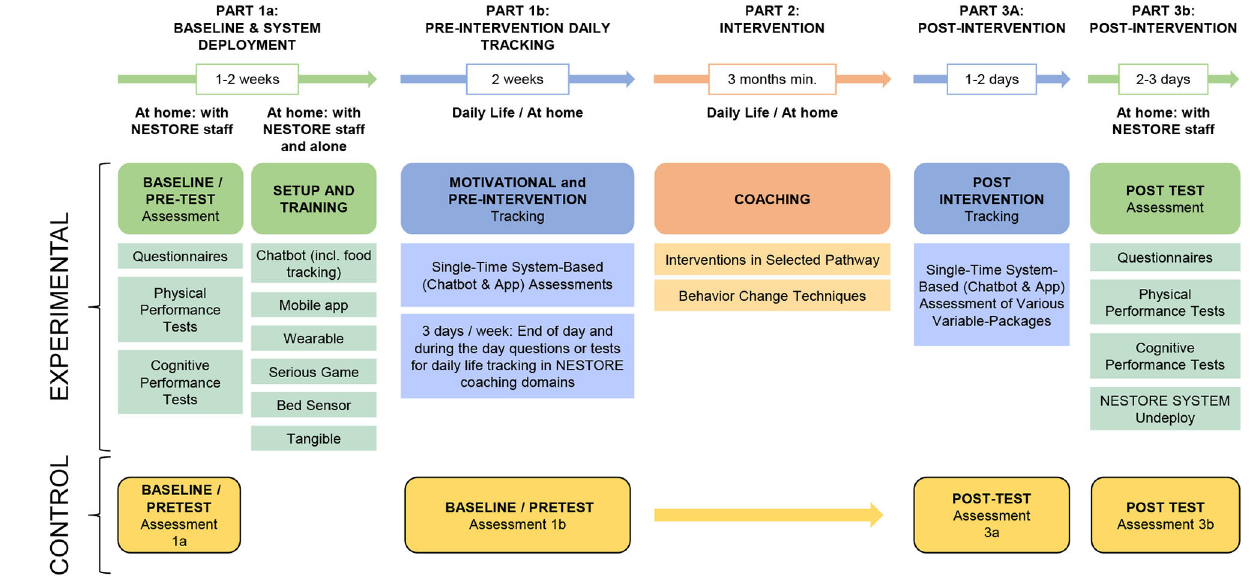
FIGURE 12 | NESTORE Study Design: Experimental and Control